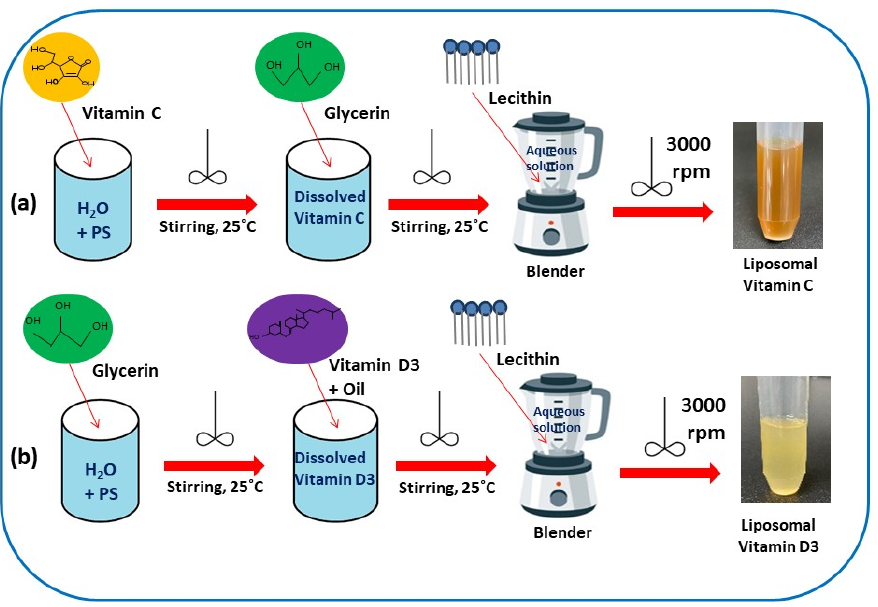
Scheme 1. Illustration of the liposome preparation method: ( a ) liposomal vitamin C, and ( b ) liposomal vitamin D3.